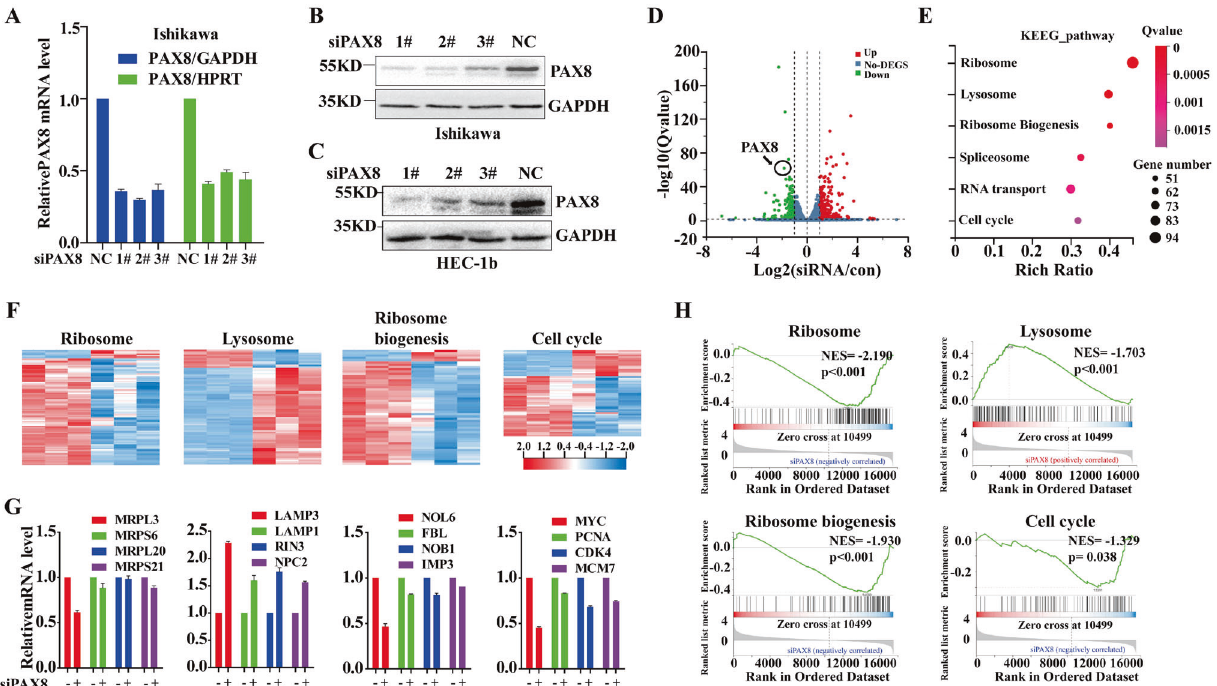
Fig. 3 siPAX8 in fl uences the expression of genes involved in ribosome biogenesis and cell cycle pathways. A Ishikawa cell was transfected with PAX8 siRNA for 24 h, RNA isolated, and RNA-Seq performed. The expression level of PAX8 mRNA after knockdown PAX8 was detected by qPCR. B , C The expression level of PAX8 protein was detected by Western blotting, after knockdown PAX8 in Ishikawa and HEC-b cells. D Volcano plots of differentially expression genes (red means up-regulated genes, green means down-regulated genes). E Categories from the top six families in KEEG pathways analysis of signi fi cant gene expression changes under siPAX8. F Differentially expressed genes clustering diagram. The columns represent different samples (three groups on the left are the siNC, and the three groups on the right are siPAX8), the rows represent different genes, and are clustered by lg (TPM + 1) value, red indicates high expression genes, and blue indicates low expression genes. G qPCR was used to verify ribosome, ribosome synthesis, lysosome, and cell cycle-related gene mRNA expression level in Ishikawa cells after knockdown PAX8. H Representative enrichment plots of the ribosome, ribosome synthesis, lysosome, and cell cycle-related gene set which positively or negatively correlate with